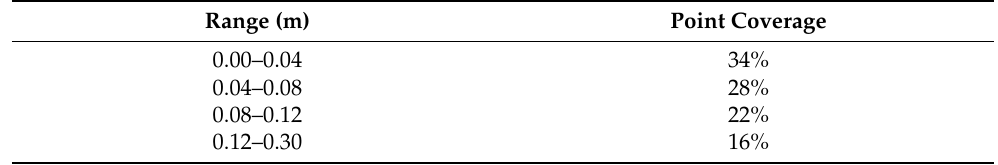
Table 7. C2C analysis L1-SX10: point coverage related to a range of distances.